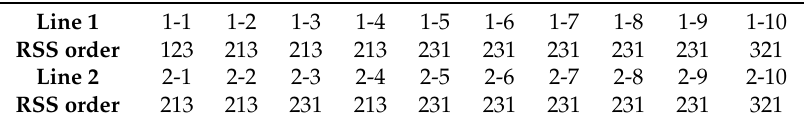
Table 1. Zones of the testbed with the same RSS